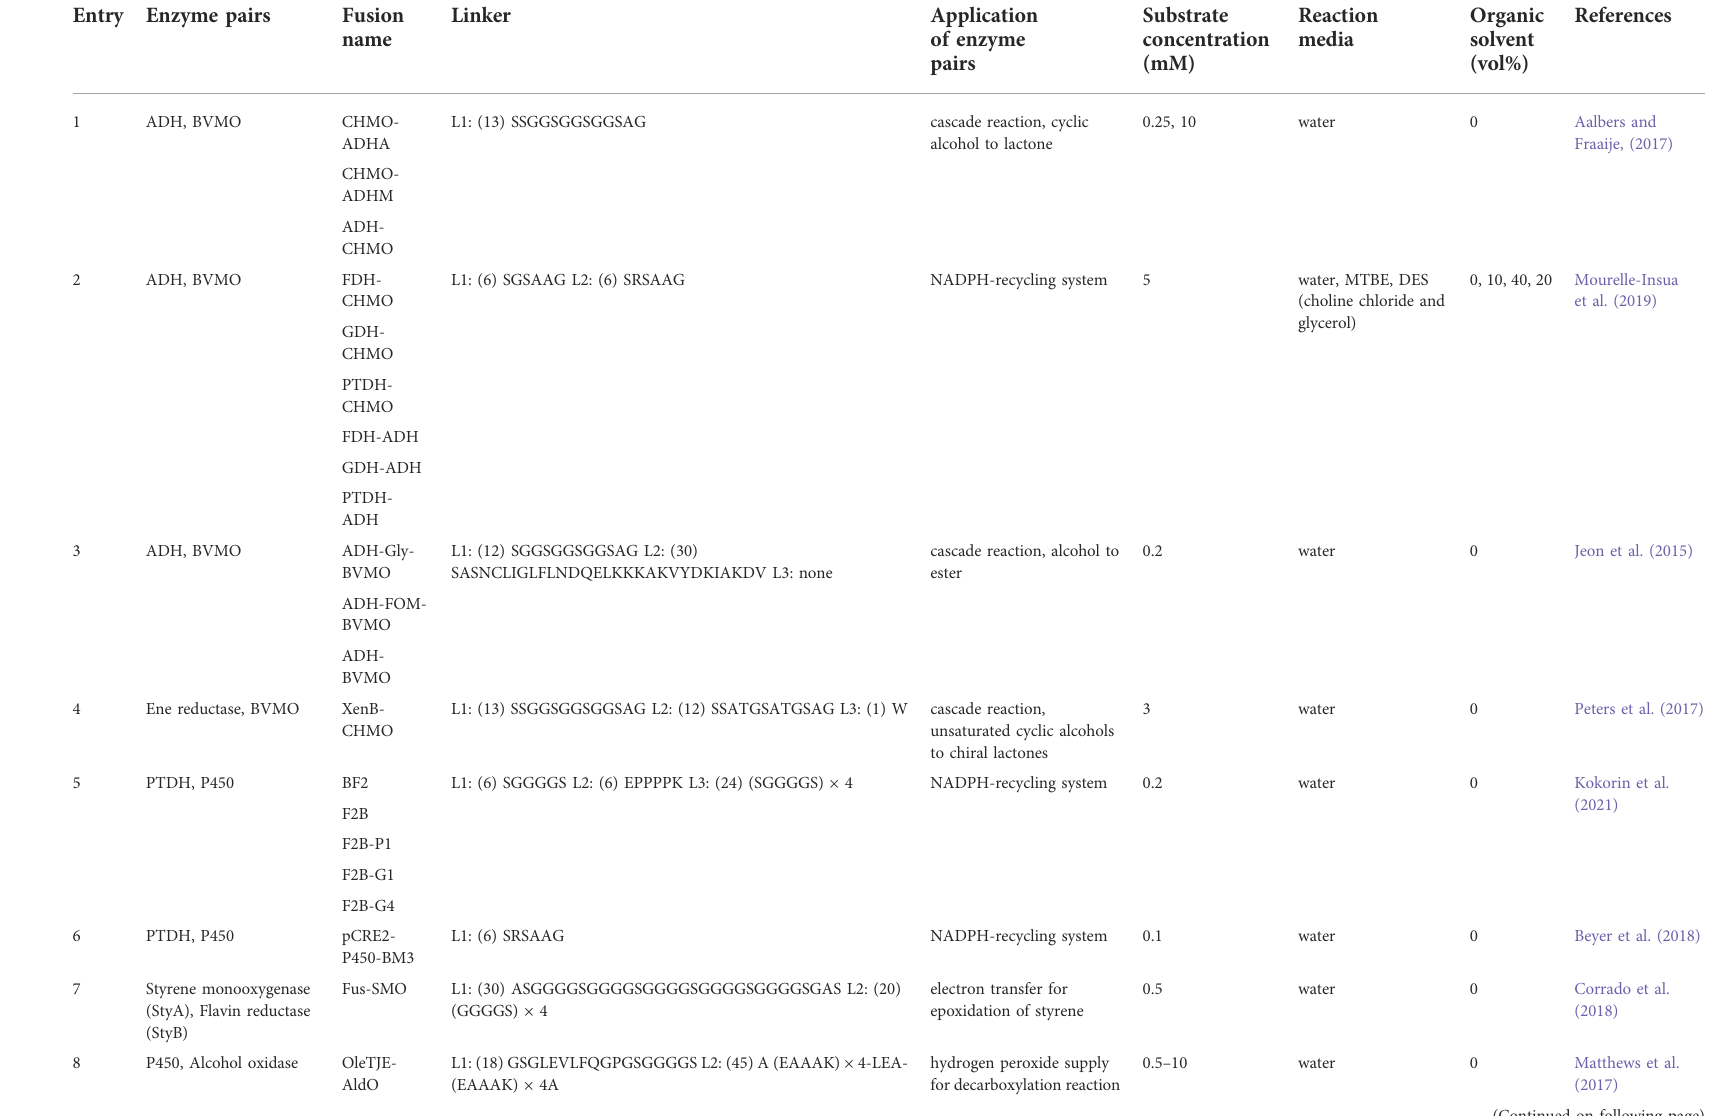
TABLE 1 List of fused and non-fused oxidoreductases, and their biocatalytic applications with varying substrate concentrations in various aqueous and non-aqueous